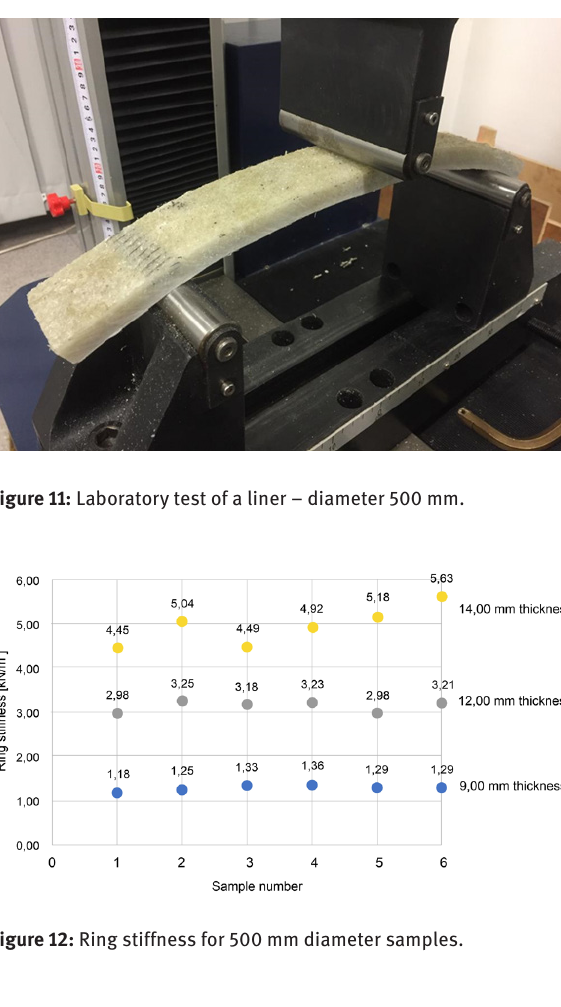
Figure 10: Ring stiffness for 350 mm diameter samples.